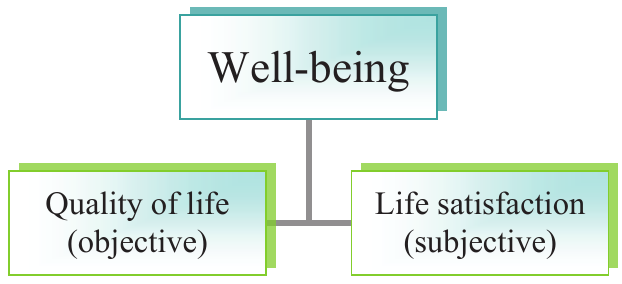
Fig. 1: Life satisfaction as a component of personal well-being